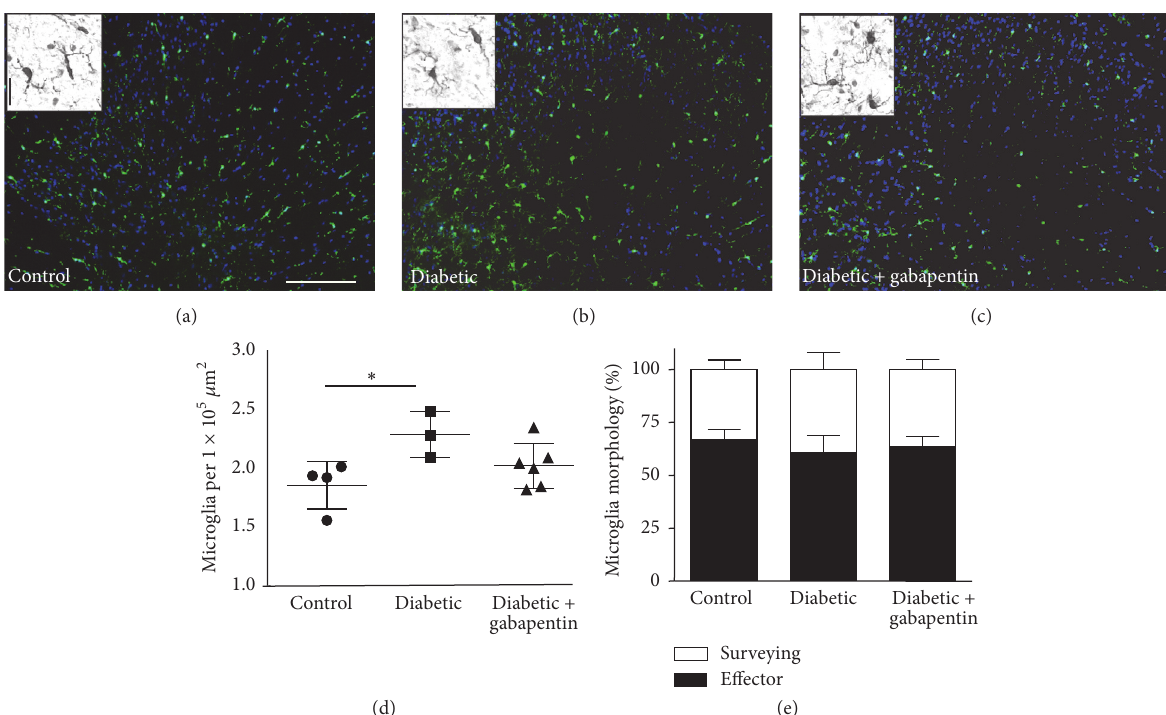
Figure 3: Microglial changes in the spinal cord of control, untreated diabetic, and gabapentin-treated diabetic rats. Representative photomicrographs of the L4/5 dorsal horn of the spinal cord of (a) control, (b) untreated diabetic, and (c) diabetic rats treated with gabapentin (a–c), micrographs (and insets) show examples of typical Iba1-immunoreactivity. Scale bars represent 100 𝜇 m (main micrograph, (a)–(c)) and 25 𝜇 m (insets (a)–(c)). Microglial numbers are increased in the superficial ((d), ∗ 𝑝 < 0.05 1-way ANOVA Bonferroni post hoc tests) but not deep (e) dorsal horn of diabetic rats; however, morphology of microglia was not significantly different